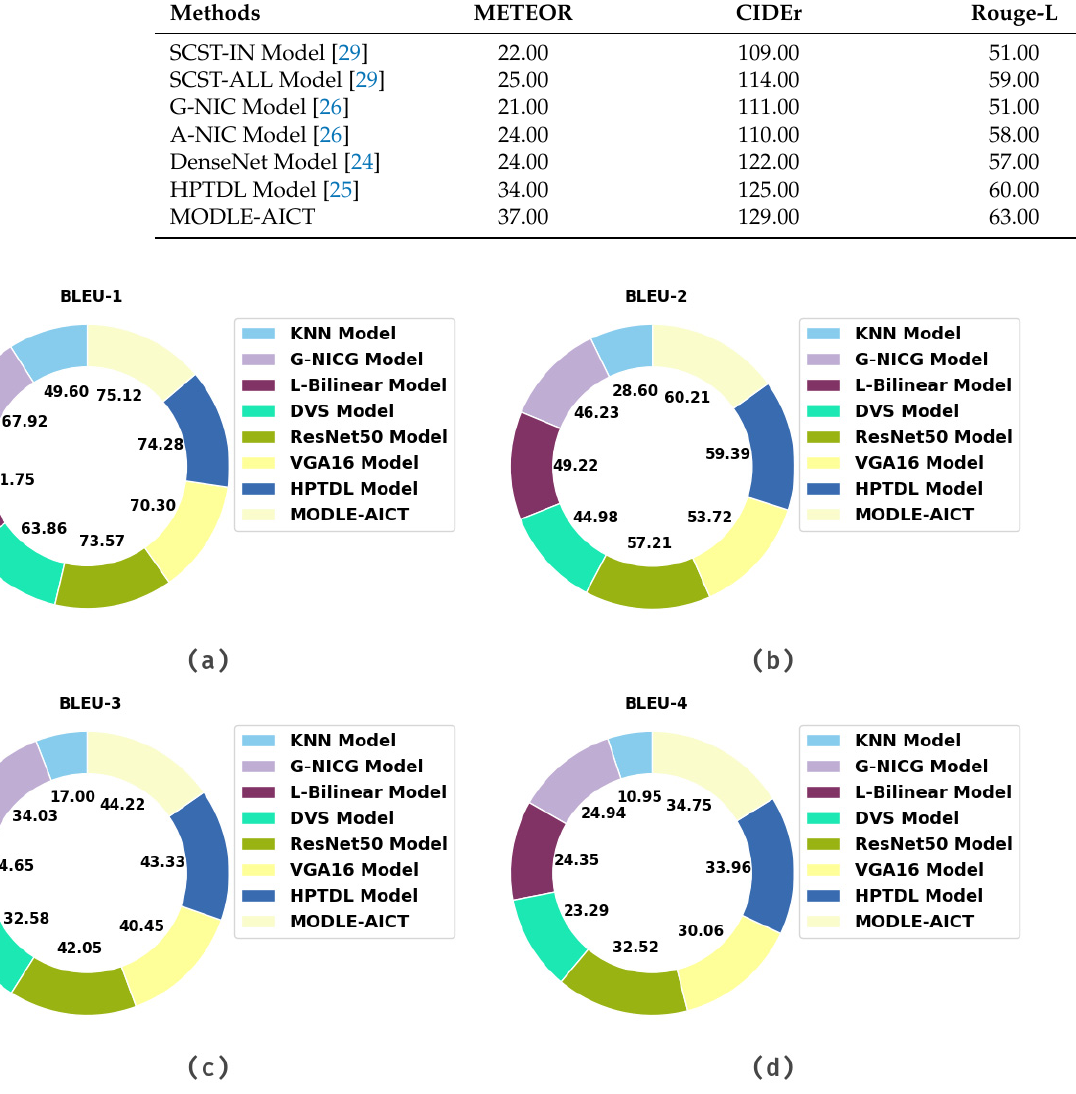
Figure 8. Result analysis of the MODLE-AICT algorithm on the MS-COCO 2014 dataset: ( a ) BLEU- 1, ( b ) BLEU-2, ( c ) BLEU-3, and ( d ) BLEU-4. Table 4. Result analysis of MODLE-AICT algorithm with approaches on MS-COCO 2014